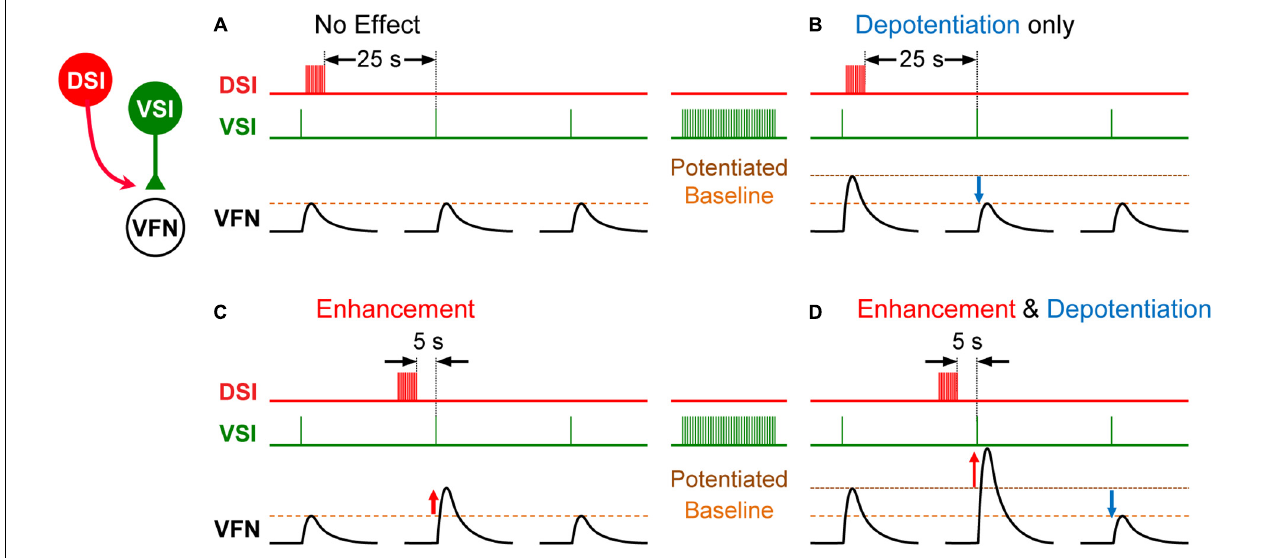
FIGURE 3 | Schematic representation showing state- and timing-dependent neuromodulation of synaptic strength by a serotonergic DSI neuron. (A) When the strength of the VSI-to-VFN synapse is at baseline, a DSI spike train delivered 25 s before the next VSI spike has no effect on the synaptic strength. (B) After a VSI spike train, the VSI synapse shows post-tetanic potentiation. When potentiated, a DSI spike train delivered 25 s before the next VSI spike depotentiates the synapse. (C) When the strength of the VSI-to-VFN synapse was at baseline, a DSI spike train delivered 5 s prior to the next VSI spike produces transient heterosynaptic enhancement (upward red arrow), which lasts for about 15 s. (D) When potentiated, a DSI spike train delivered 5 s prior to the next VSI spike produces transient enhancement and a subsequent depotentiation of the synapse. DSI spike train (red trace), VSI spikes (green trace), and the synaptic potentials in VFN (black traces) are shown in each. In each trace, single VSI spikes each produce EPSPs in the postsynaptic VFN neuron. Changes in the synaptic strength are indicated by dashed lines (baseline, potentiated).